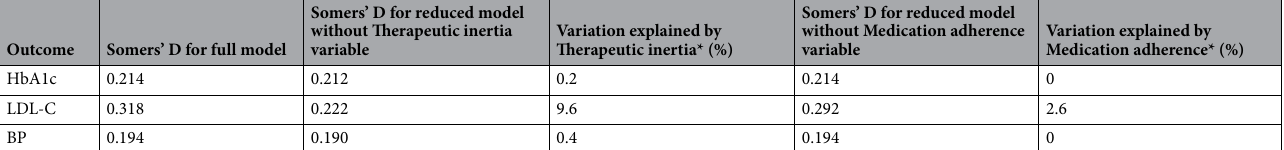
Table 4. Variation explained by proportion of days covered (PDC) and therapeutic inertia: *Difference between Somers’D for full model and reduced model.